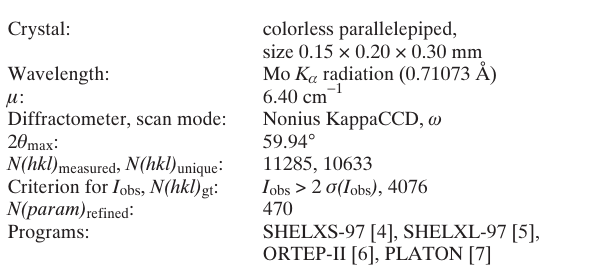
Table 1. Datacollection and